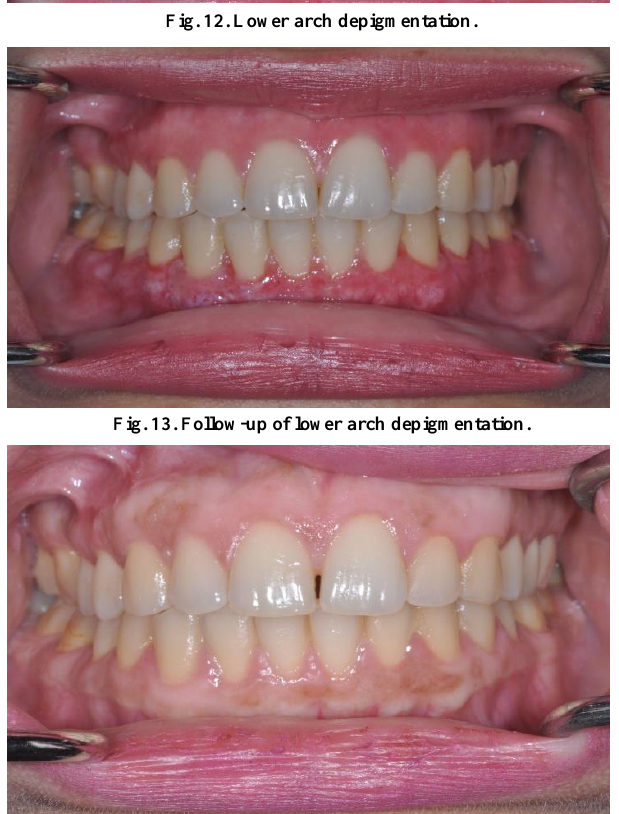
Fig. 14. Three years